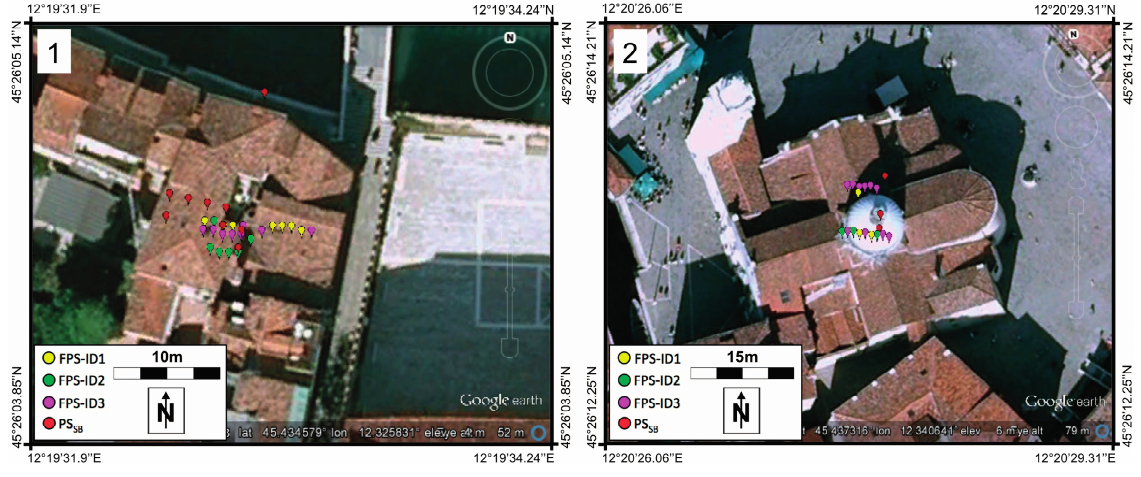
Figure 4. Close-ups of FPS and PS indicated in Figure 2A with the labels 1 and